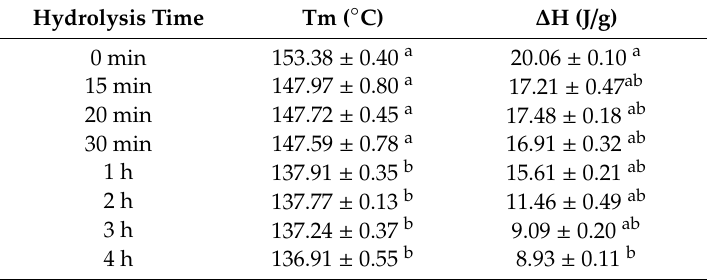
Table 2. Thermal properties of dried hydrolysed collagen powder at di ff erent times of hydrolysis. Average value of three replicates. Values followed by di ff erent letters are significantly di ff erent according to Tukey’s test ( p ≤